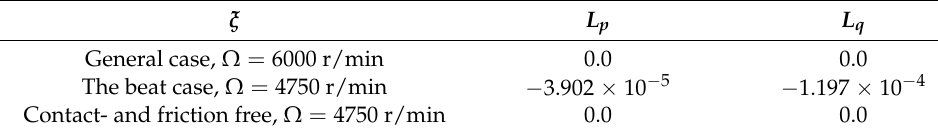
Table 2. Factors of localization of vibration in different cases.